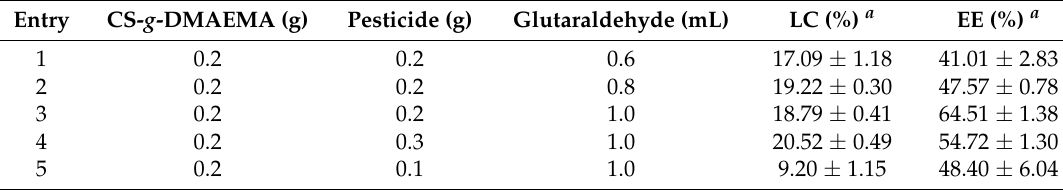
Table 1. The loading content (LC) and encapsulation efficiency (EE) of pyraclostrobin into CS- g -DMAEMA microcapsules.